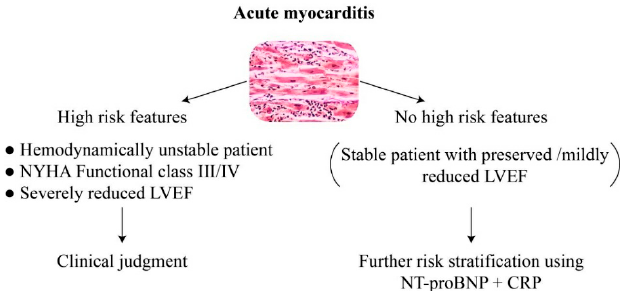
Figure 1. Simple risk stratification in acute myocarditis using echocardiography, clinical parameters, natriuretic peptide, and CRP. NYHA New: York Heart Association; LVEF: Left Ventricular Ejection Fraction; NT-proBNP: N-terminal-pro hormone Brain Natriuretic Peptide; CRP: C-reactive protein. In unstable patient or those with acute heart failure, biomarkers are less relevant for risk assessment, and patients should be treated in accordance with the guidelines of heart failure and the common practice. In patients with preserved or mildly reduced LVEF (40–50%), the use of NT-proBNP and CRP may be preferred over troponin for risk stratifica- tion.